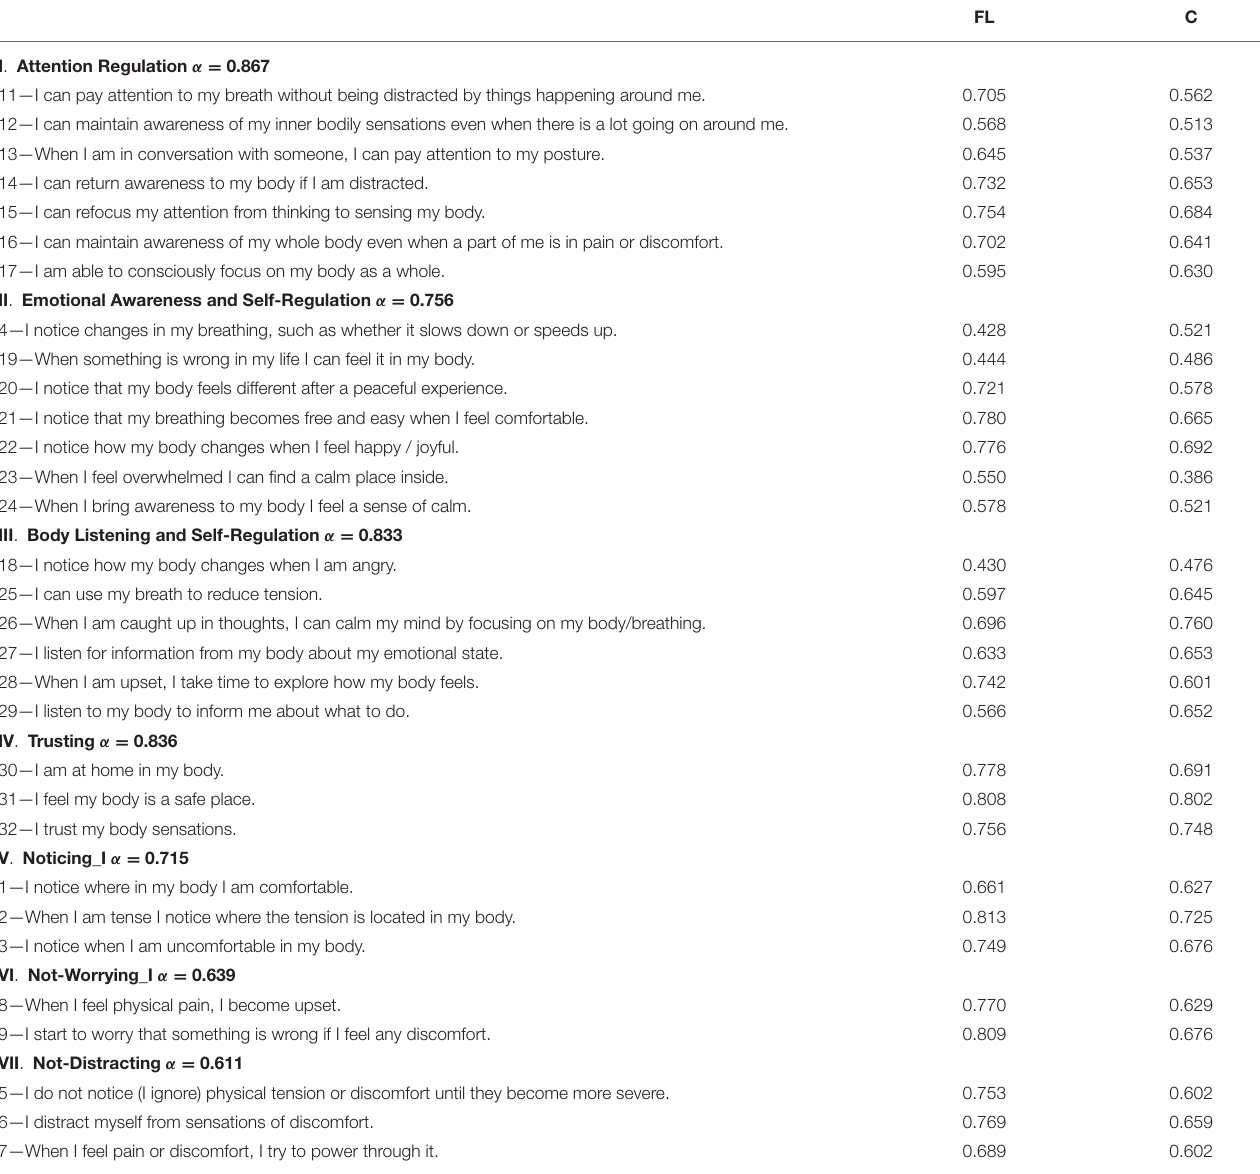
TABLE 9 | Exploratory PCA of the MAIA items in Indian participants.